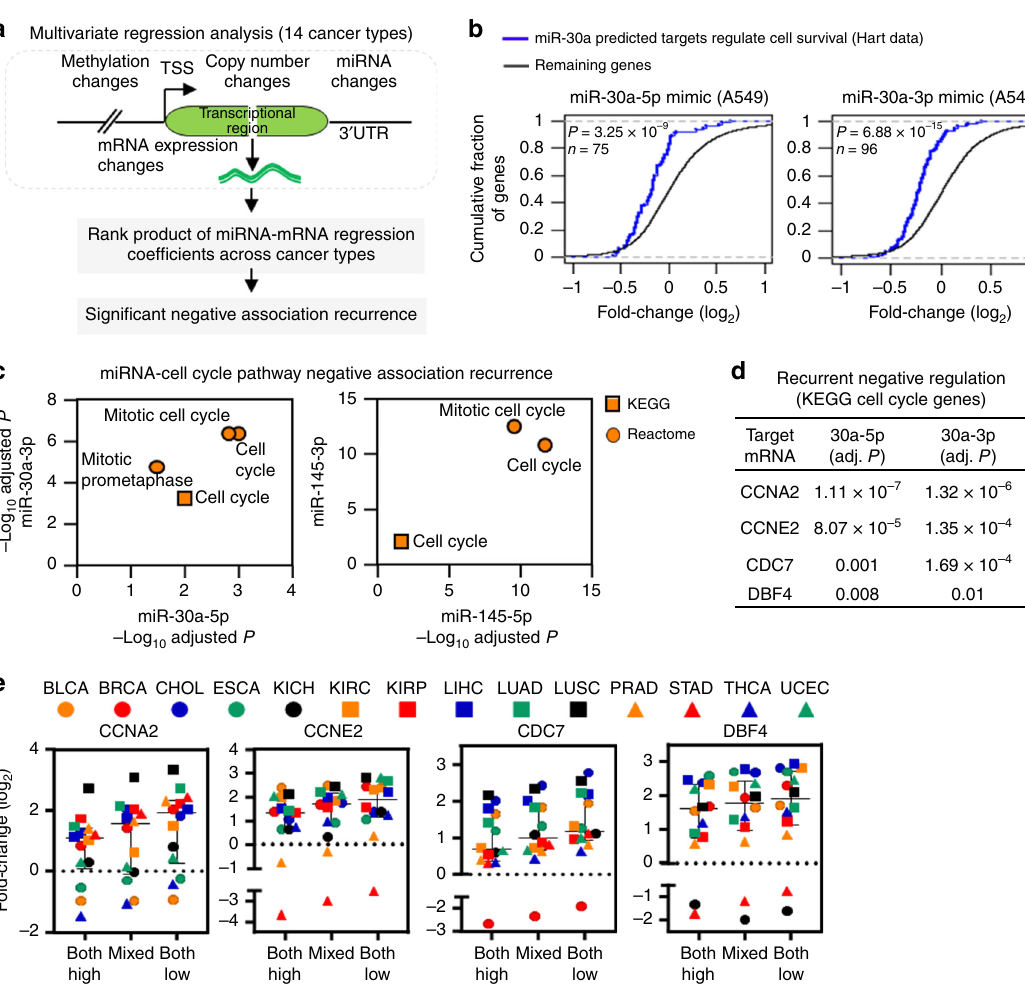
Fig. 5 Cooperative effects of miRNA 5p/3p-mediated gene regulation in cancer cell proliferation and movement. a Identifying miR-30a and miR-145 5p/ 3p-mediated gene expression changes across 14 cancer types. A linear regression function was modeled to predict miRNA – mRNA association after controlling for the impact of DNA methylation and gene copy number changes. The rank product statistic was employed to aggregate the miRNA – mRNA regression coef fi cients across the 14 cancer types and predict signi fi cant miRNA – mRNA-negative association recurrence (BH adjusted P < 0.05). b Expression changes of miRNA-target essential genes after transfection of the miR-30-5p or 3p mimics in A549 lung adenocarcinoma cells (the miRNA perturbation pro fi le from our RNA-seq data, GSE142695). The miRNA-essential gene pairs were obtained from regression analysis in TCGA LUAD. Indicated P -values were determined from two-tailed Kolmogorov – Smironov test. n denotes number of predicted target essential genes of the corresponding miRNA. We extracted a common essential gene list from the Hart laboratory (http://hart-lab.org/). c Pathway enrichment analysis to determine